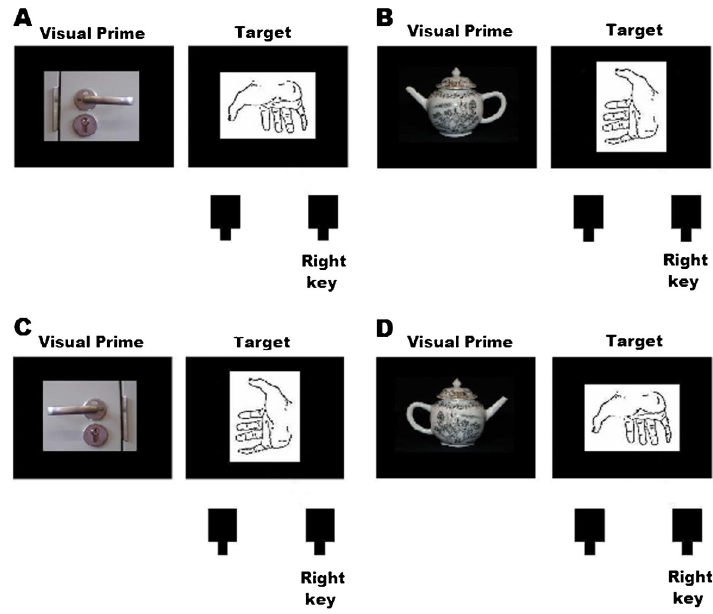
Figure 1. Experimental setup: A and B show a correspondent and matching conditions, respec- tively. In both, the action afforded by the visual object is right handed, while the target is a drawing of the right hand in the afforded posture. C and D show non-correspondent and non- matching conditions,